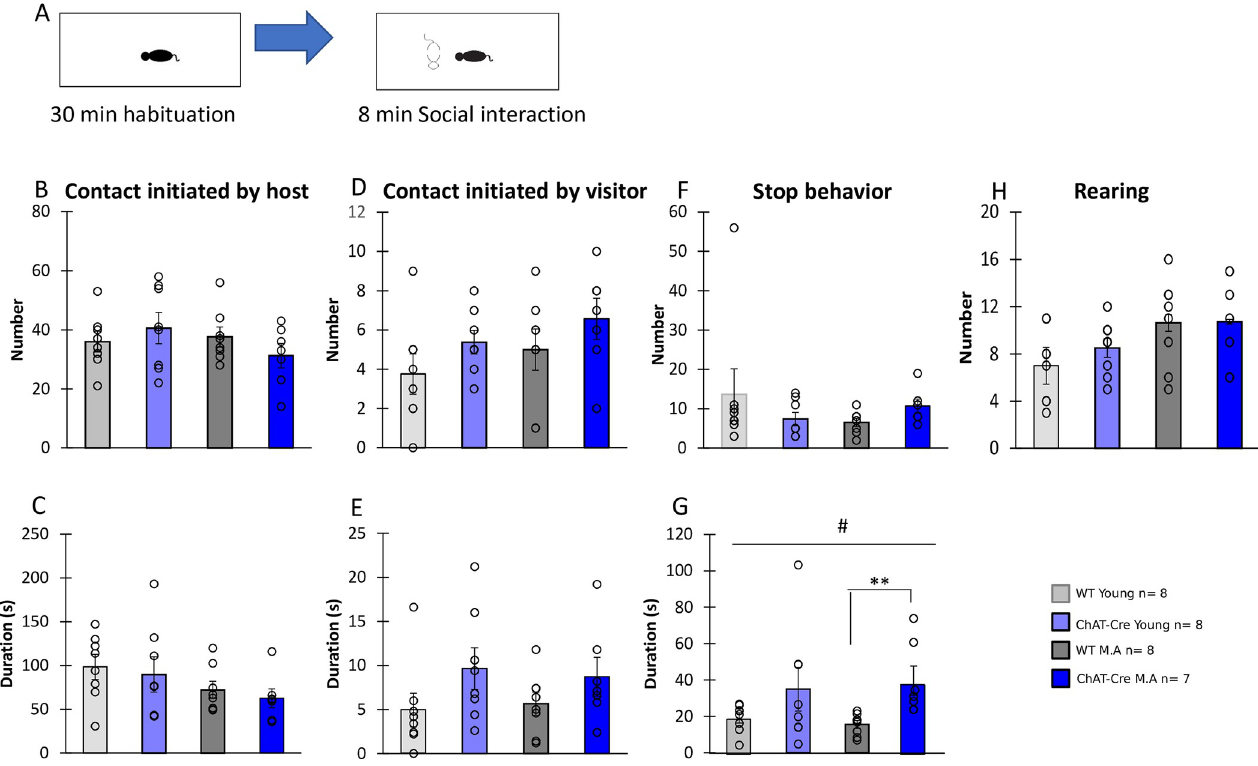
Fig 2. Contact; stop and exploration in the Social Interaction Task. A) Schematic representation of the social interaction task. B) Number of contacts initiated by Host mice. C) Duration of contact initiated by Host mice. D) Number of contacts initiated by Visitor mice. E) Duration of contact initiated by Visitor mice. F) Number of stops episodes. G) Duration of stop episodes. H) Number of rearings made by Host mice. Host mice were previously isolated for 3 weeks and exposed to the novel experimental environment for 30 minutes before being presented with a visitor mouse: WT young n = 8, ChAT-Cre young n = 8, WT Middle Age n = 8, ChAT-Cre Middle Age n = 7. Visitor mice (young n = 6 and middle age n = 6) were WTs of same age and sex maintained in a social cage before the experiment. Data are presented as means ± SE; � p < 0.05; �� p < 0.01; ��� p < 0.001; Kruskal-Wallis rank-sum test analysis then Wilcoxon and d signed-rank tests were applied when appropriate. # represents the genotype effect and ◆ the age effect. Kruskal-Wallis results were not represented for simplicity.